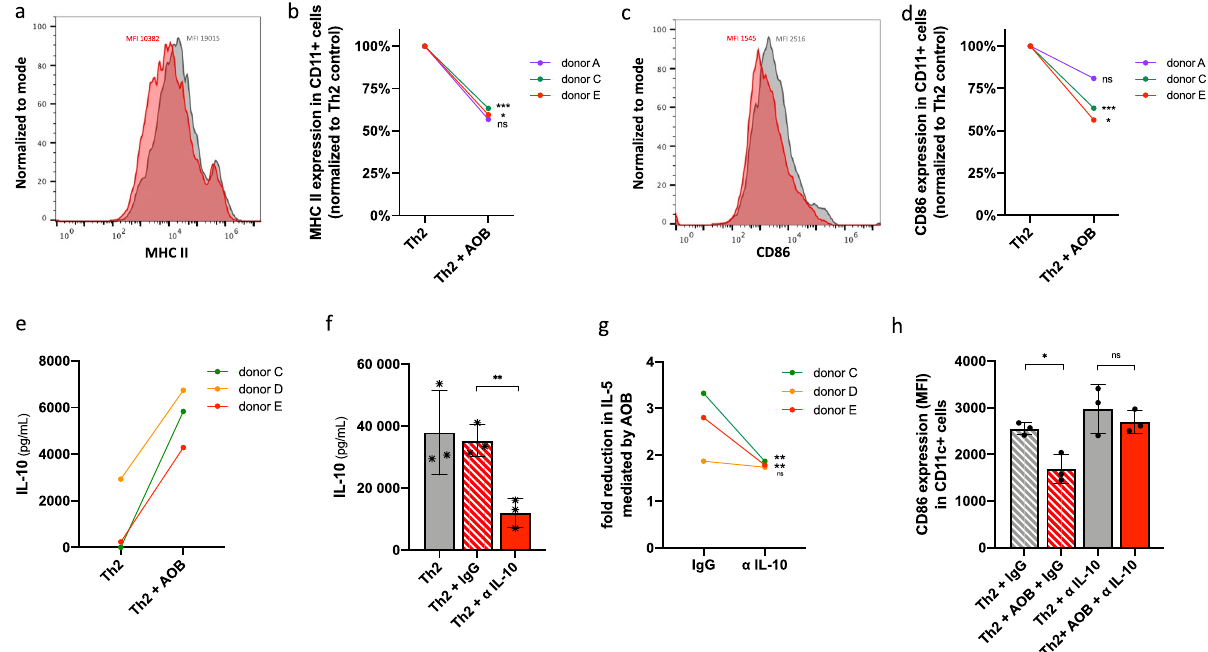
Figure 3. AOB-mediated Th2 inhibition requires IL-10 and is associated with a suppression of dendritic cell activity. ( a – d ) Expression of MHC II ( a , b ) or CD86 ( c , d ) in CD11c+ cells is reduced in PBMC treated with AOB prior to Th2 differentiation cocktail stimulation; measured by flow cytometry in Th2-stimulated PBMC in the presence or absence of AOB. ( a , c ) Representative fluorescence intensity plots of anti-MHC II FITC ( a ) or anti-CD86 PE ( c ) stained PBMC from donor C in the presence (red) or absence (grey) of AOB. ( b , d ) Relative MHC II ( b ) or CD86 ( d ) expression in CD11c+ positive cells is reduced with AOB treatment in 3 donors (n = 3 per donor, unpaired t-test, p < 0.0001 for MHC II and CD86 aggregated donor datasets). ( e ) IL-10 production is induced by AOB in PBMC from 3 donors 24 h post-stimulation; measured by ELISA of culture